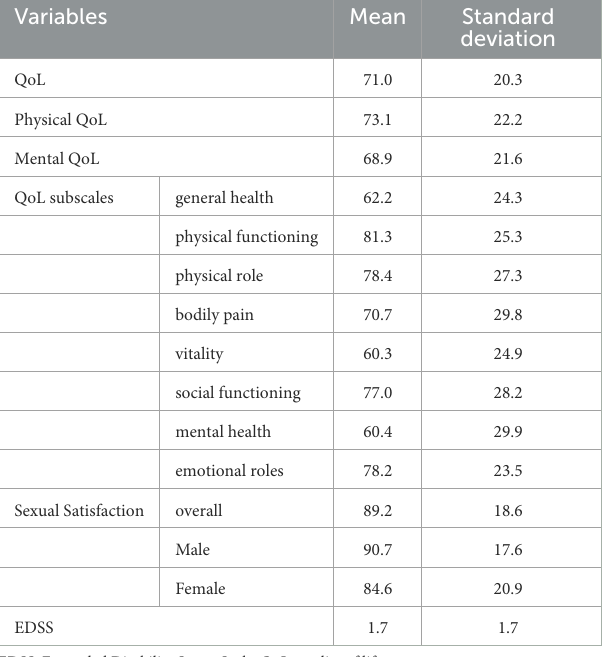
TABLE 2 Mean and standard deviation of QoL and its dimensions, as well as sexual satisfaction in spouses and EDSS in MS patients. Variables Mean Standard